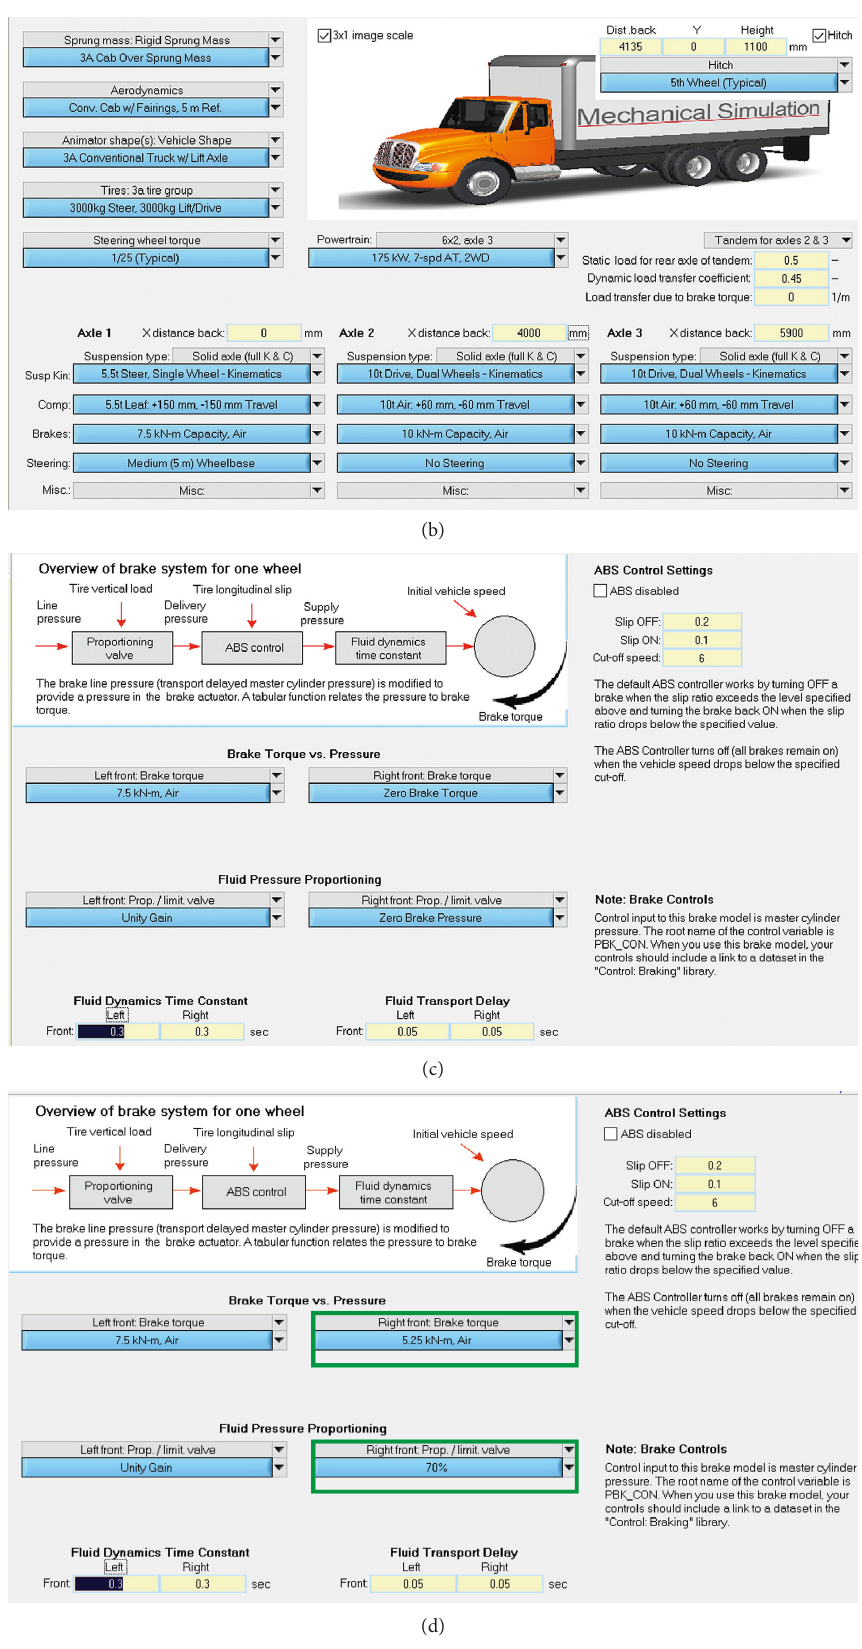
Figure 12: Multi-body dynamic model diagram. (a) Vehicle tire parameters. (b) Vehicle physical model parameters. (c) Right front wheel complete brake failure model. (d) Incomplete braking failure model of right front